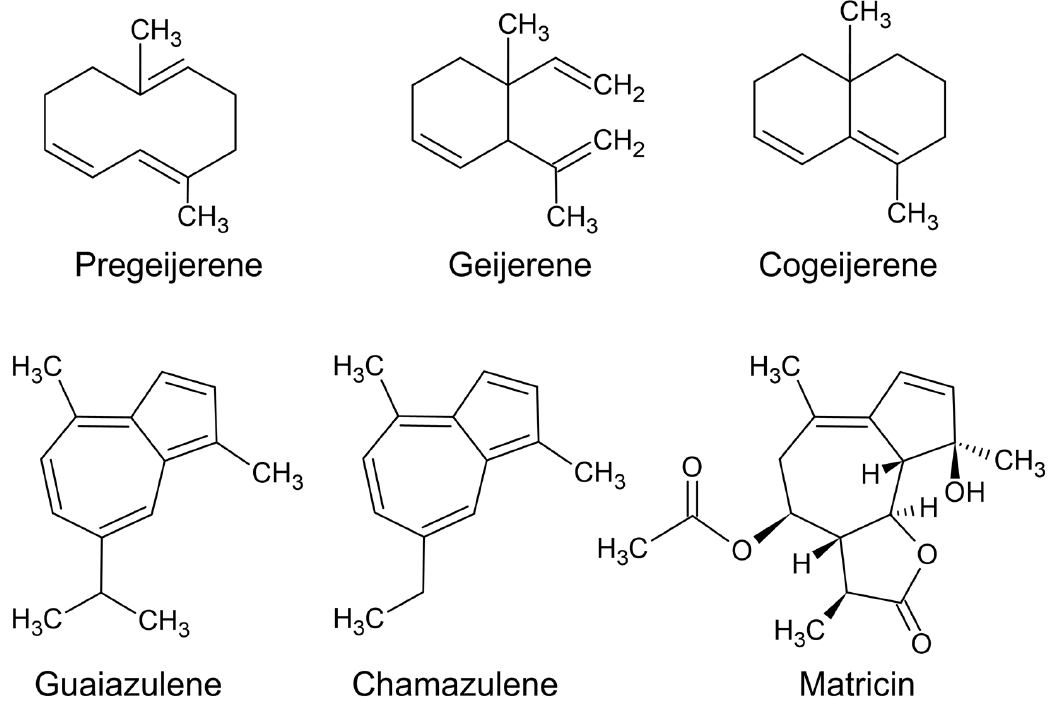
Figure 9. Compounds that confer colour to an essential oil. Green components are pregeijerene, geijerene, and cogeijerene; blue components are guaiazulene and chamazulene, and matricin is a heat labile precursor to chamazulene.